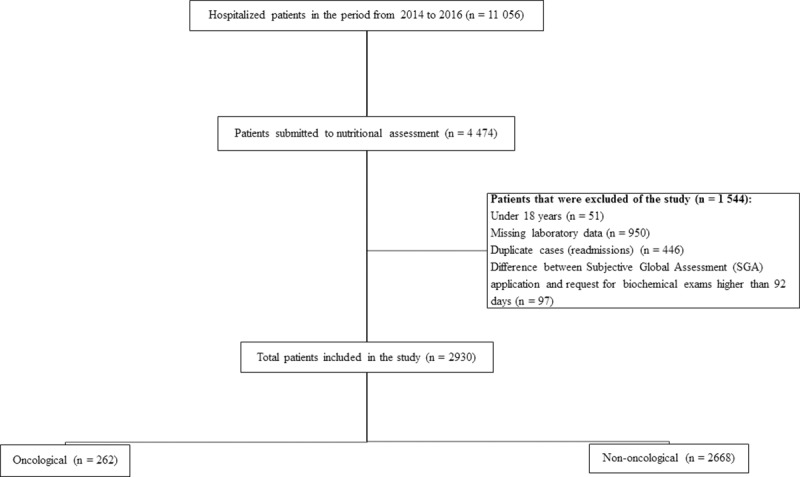
Diagram describing the process of selection of the study participants.